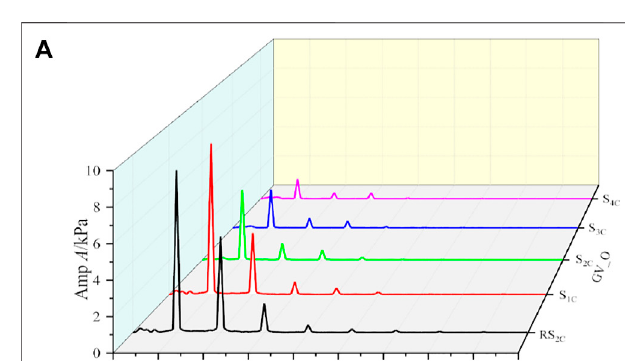
Frontiers in Energy Research |